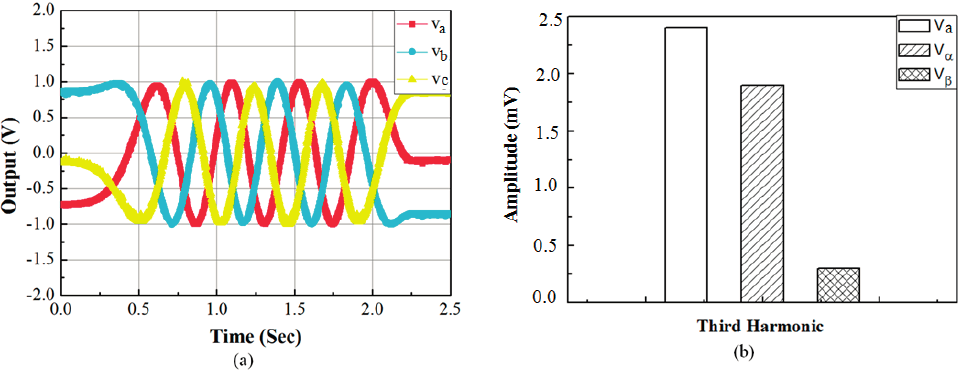
Figure 9. ( a ) Three phase signal obtained from proposed method; ( b ) Third harmonic components before and after three to two phase transformation.